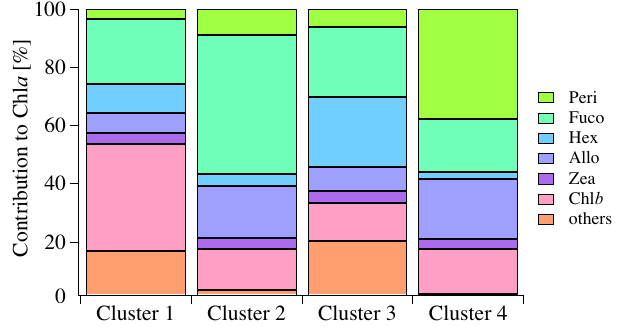
Fig. 3. Average percent contribution to chl a of major algal acces- sory pigments for each cluster. These contributions were determined by multiple regression